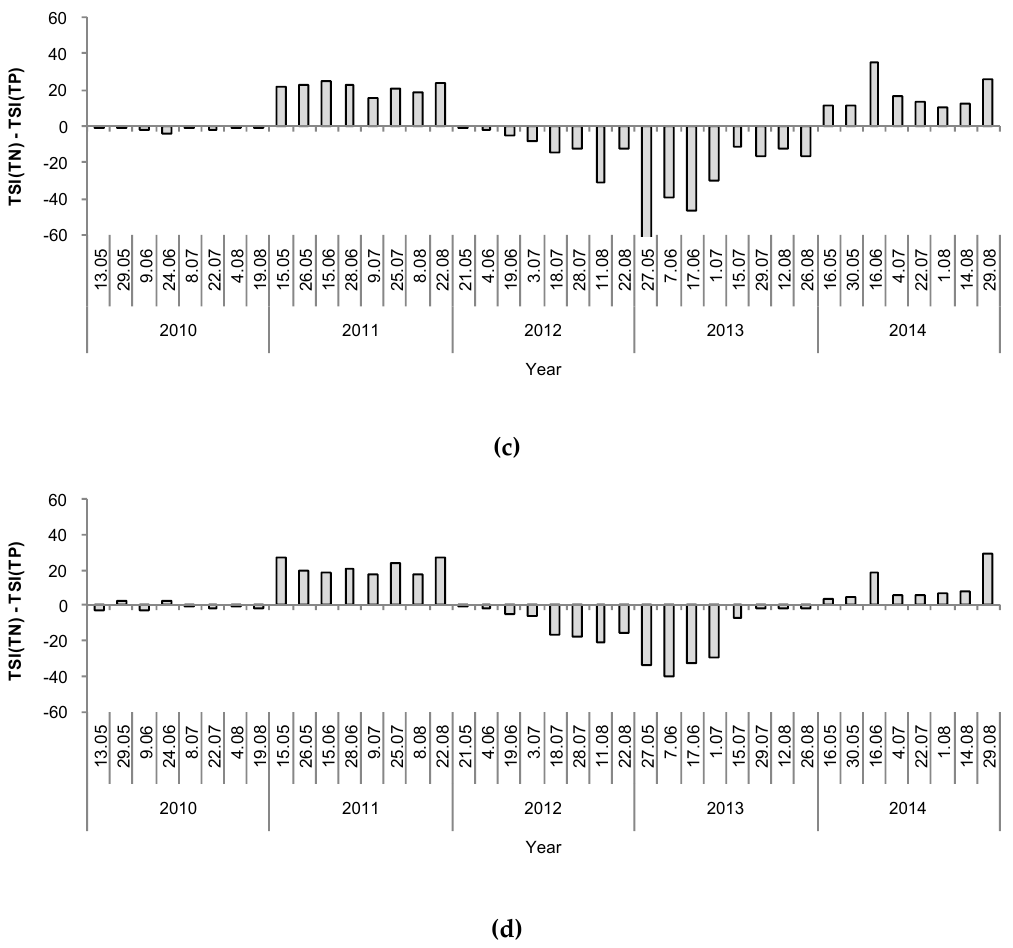
Figure 7. Temporal deviations in the values of trophic state indices (TSI(TN)-TSI(TP)) during the investigation period (2010–2014) in the studied lakes: ( a ) G łę bokie; ( b ) Gumienek; ( c ) Czarne; ( d ) Ma ś luchowskie.